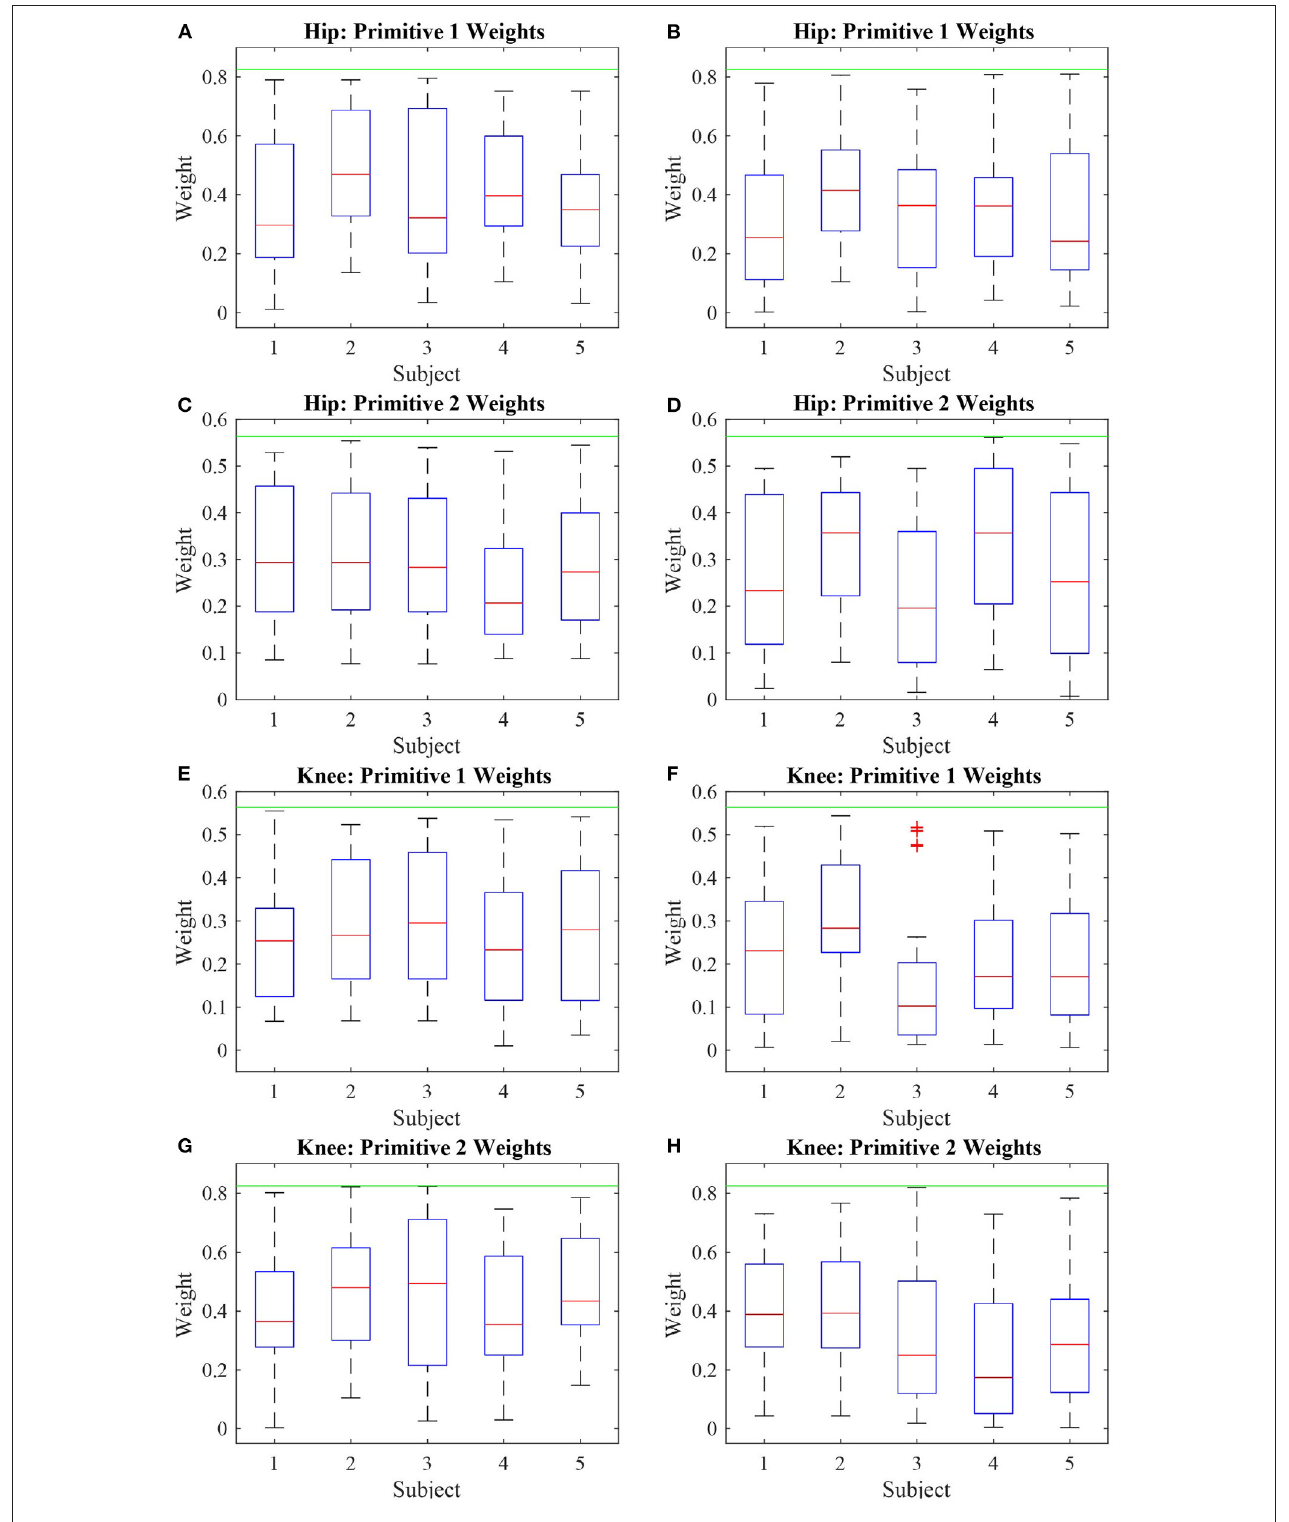
FIGURE 10 | Boxplot of the absolute value of the deficient weights of five subjects performing two modes of walk: active (A,C,E,G) and passive (B,D,F,H) . It can be noted that the weights with respect to the first primitive are more affected than the weights related to the second primitive, due to the knee actuation and the absence of actuation at the hip